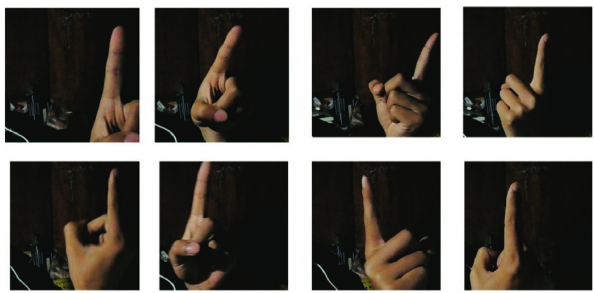
Figure 7: Different data for the same